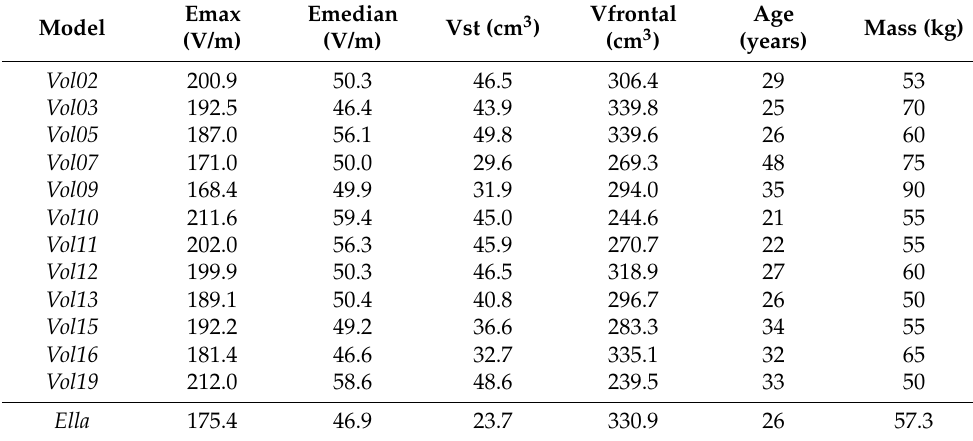
Table A2. Stimulation metrics (Emax, Emedian, and Vst) on the frontal lobe and model parameters (frontal lobe volume, age, mass) of the anatomical female models and the Ella ViP model.